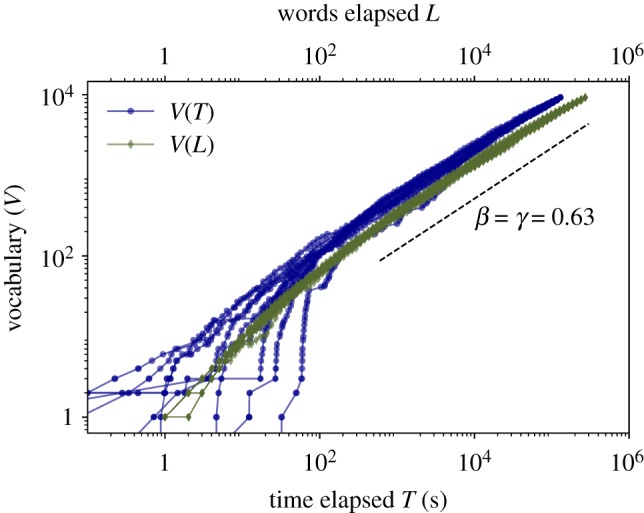
Herdan’s Law. Sublinear increase of number of different words (V) used during spontaneous speech versus time elapsed T (blue circles) and total number of words spoken L (green diamonds), where each line is the result of a different permutation in the way of concatenating the different speakers of the multi-author corpus (10 permutations). After a transient range, we find a robust scaling regime V∼Lβ and V∼Tγ for about three decades. The exponents coincide β = γ ≈ 0.63 (see the text for a justification).